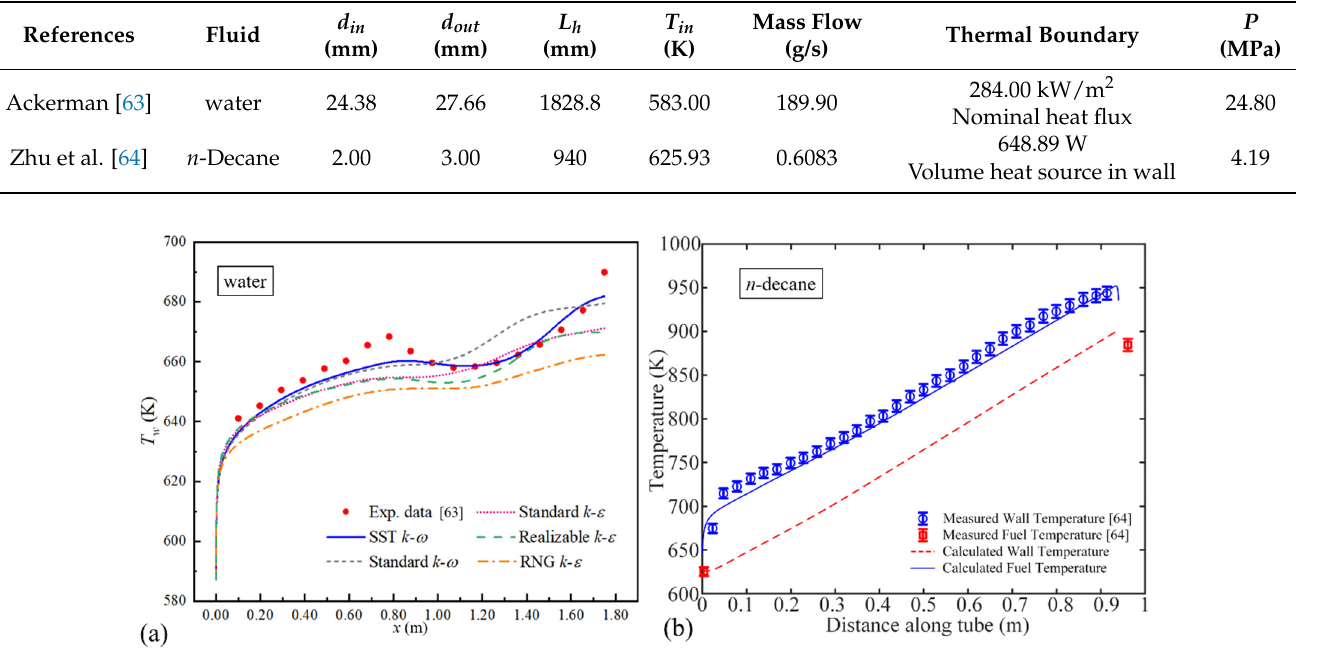
Figure 3. Validation of turbulent models by comparison with published experimental data: ( a ) wall temperature for water; ( b ) wall/bulk temperature for n -decane.